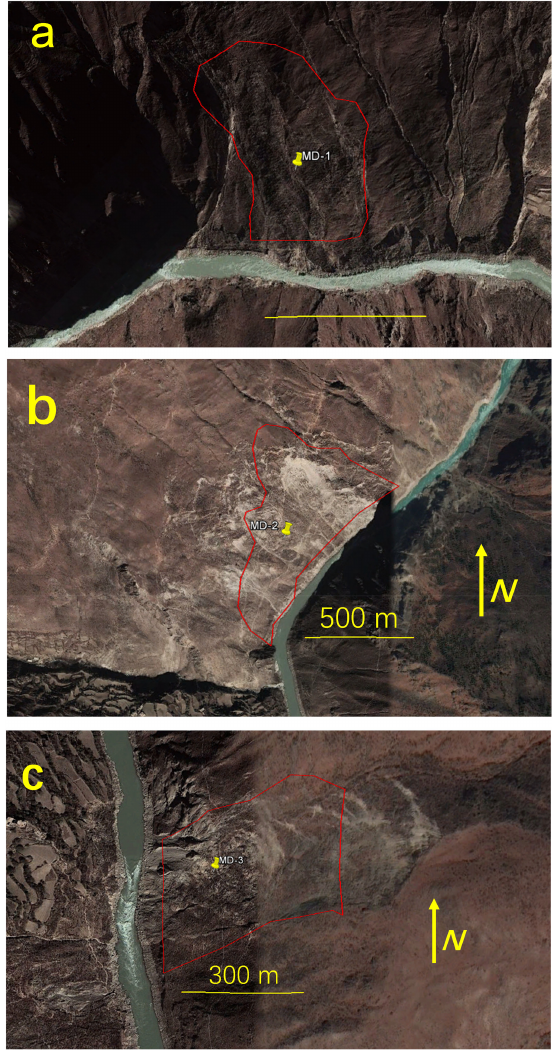
Figure 9. Tensile cracks on major hillslopes before the 2018 Baige floods as shown by high-spatial-resolution images from © Google